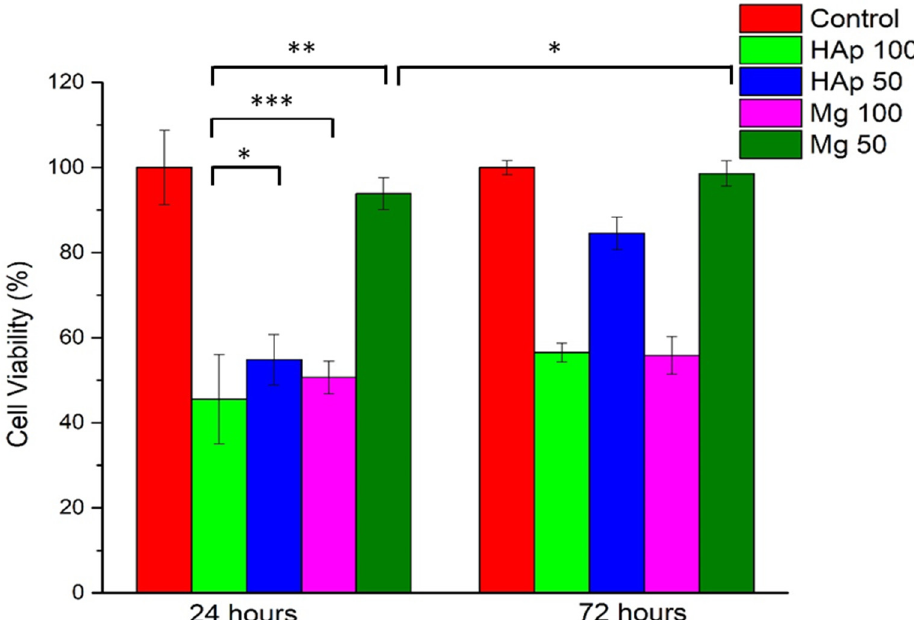
Figure 12. The cell viability, measured by the MTT assay for indirect contact (extracts), where 100 represents 100% extract and 50, 50% extract. Values were expressed as the mean ± SD from three independent experiments ( n = 3). Each value represents the mean ± standard error mean ( n = 3). * p < 0.01, ** p < 0.001, and *** p < 0.0001 versus control (analyzed by means of two-way ANOVA with Tukey’s post hoc analysis).